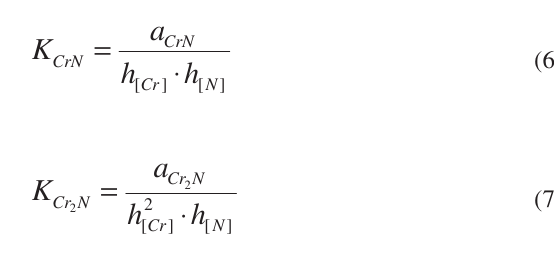
isobars overlaid; b) considering the 2